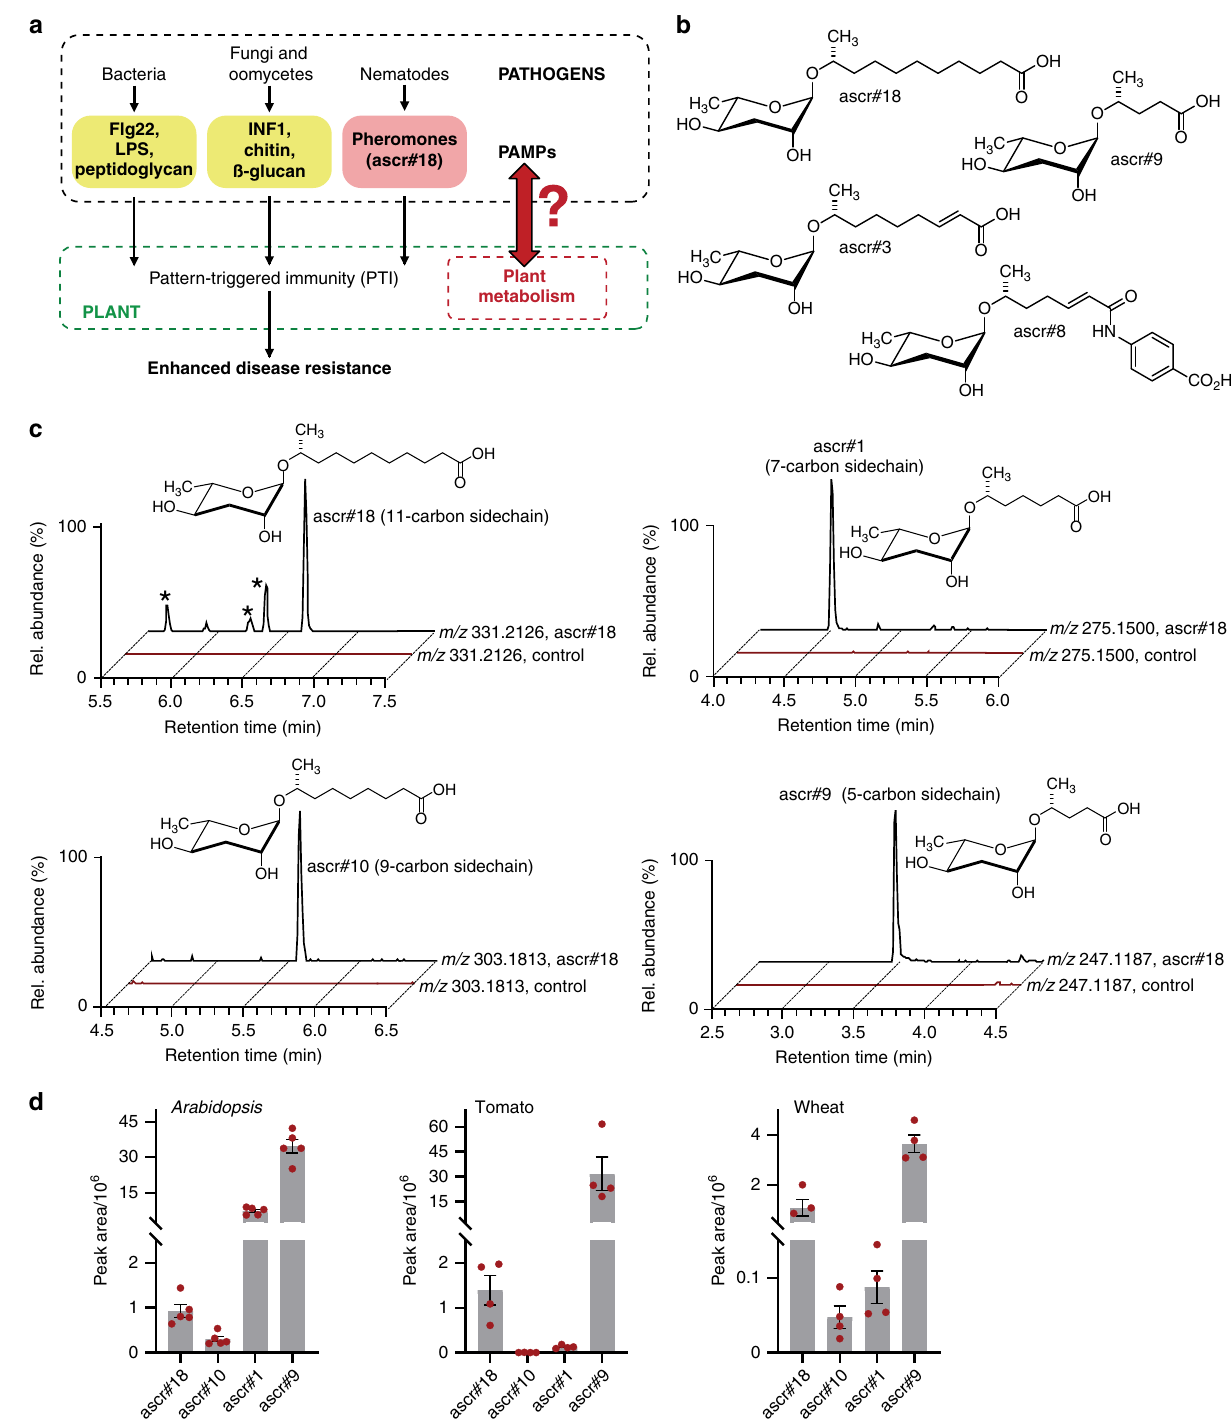
Fig. 1 Accumulation and metabolism of nematode-derived ascr#18 in plants. a Recognition of nematode-derived ascr#18 activates pattern-triggered immunity (PTI) in plants, similar to pathogen-associated molecular patterns (PAMPs) derived from other microbes. b Examples for ascarosides previously discovered in C. elegans and other nematode species. c LC-MS analysis of Arabidopsis roots treated with 1 µ M ascr#18 for 24 h, showing extracted ion chromatograms [EIC] in ESI - of ascr#18, ascr#10, ascr#1, and ascr#9. Peaks marked with an asterisk represent unrelated metabolites of similar m / z . d Accumulation of ascarosides in Arabidopsis , tomato, and wheat roots treated with 1 µ M ascr#18 for 24 h. Abundances of ascarosides are shown as the peak area, as measured in LC-MS. Data are mean ± SEM ( n = 5) (also see Supplementary Fig. 1). Source data are provided as a source data fi including ascr#18 and the identi fi ed ascr#18 metabolites, are compounds may be derived from ascr#18 via β -oxidation. produced via peroxisomal β -oxidation from longer-chained pre- Mitochondrial and peroxisomal β -oxidation are highly conserved cursors 29 . Given the nematode precedent, and since fatty acid metabolic pathways that iteratively shorten straight-chain fatty degradation in plants mostly occurs via the β -oxidation pathway acids in two-carbon increments. In nematodes, ascarosides,